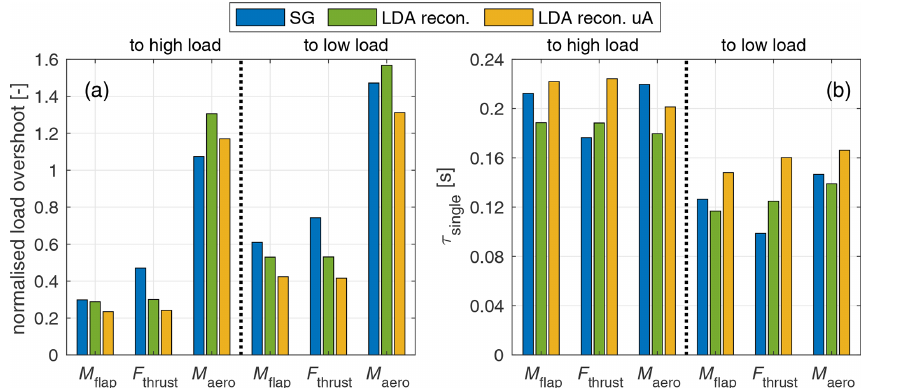
Figure 21. (a) Comparison of the amount of overshoot of the integral turbine loads M flap , F thrust and M aero , obtained by strain gauges and reconstructed from LDA measurements without and with uA model for both pitch directions. (b) Comparison of the τ single fit of the one-time-constant model to these integral loads.